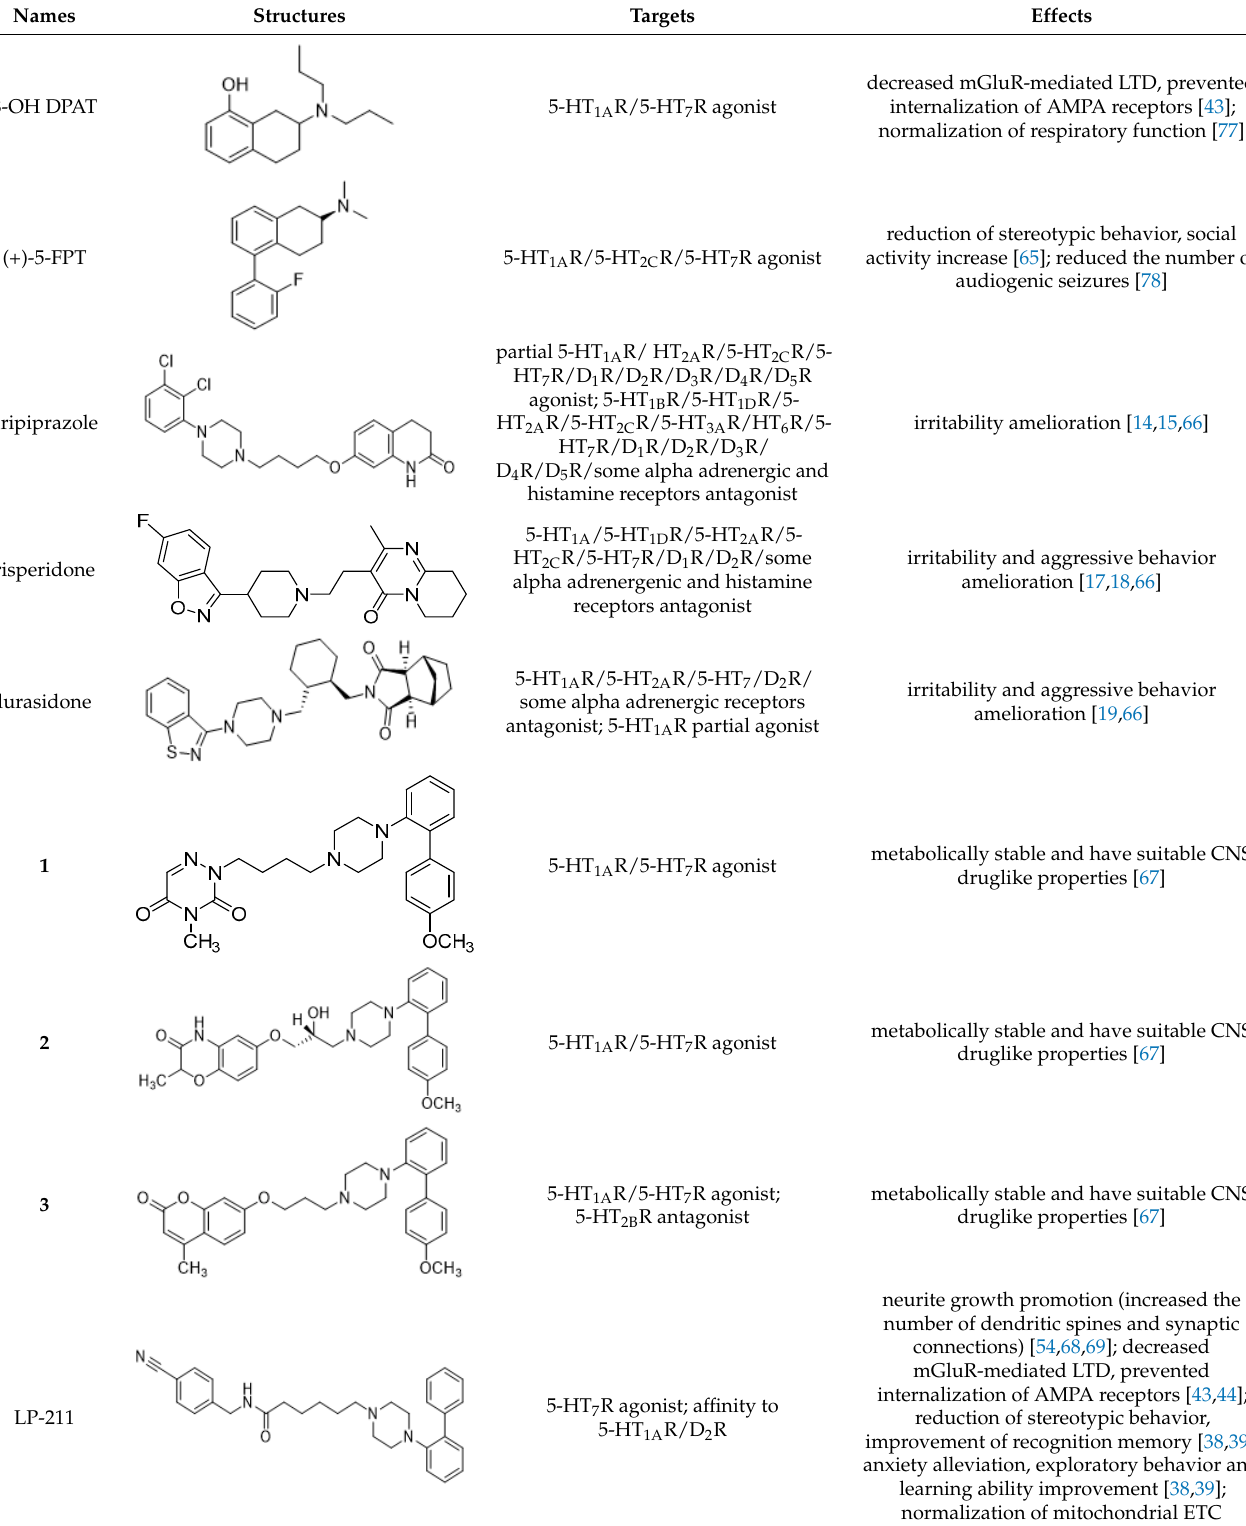
Table 1. Pharmacological agents which have potential effects on ASD and neurodevelopmental disorders treatment.